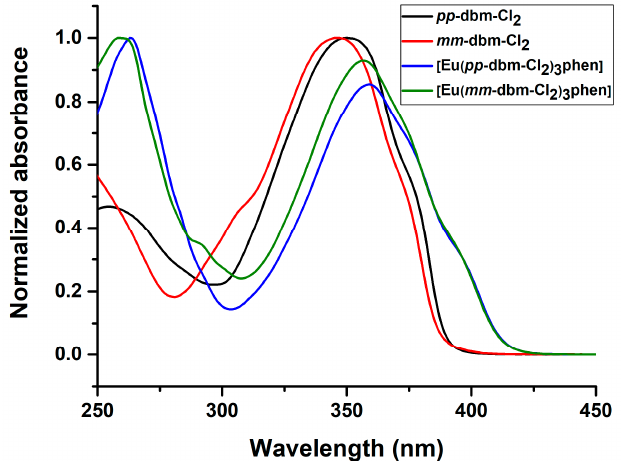
Figure 4. Normalized UV-vis absorption spectra of pp -dbm-Cl 2 , mm -dbm-Cl 2 , [Eu( pp -dbm-Cl 2 ) 3 phen], and [Eu( mm -dbm-Cl 2 ) 3 phen] in THF, 10 µM.